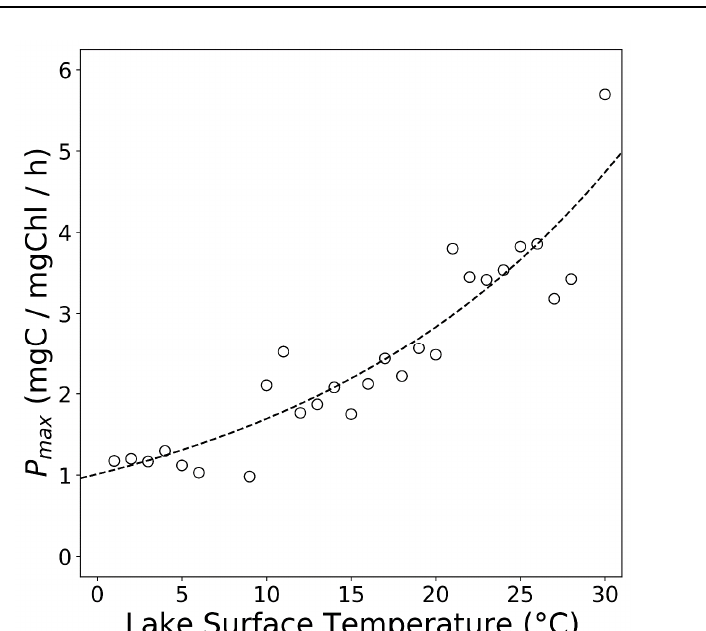
Figure 2. Maximum photosynthetic rate (P max ) plotted against lake surface temperature from large freshwater lakes in Africa and North America (bin averaged 1 ◦ C). The exponential relationship ( y = 1.012 × e 0.0515 x ) was highly significant ( p -value < 0.001, R 2 =